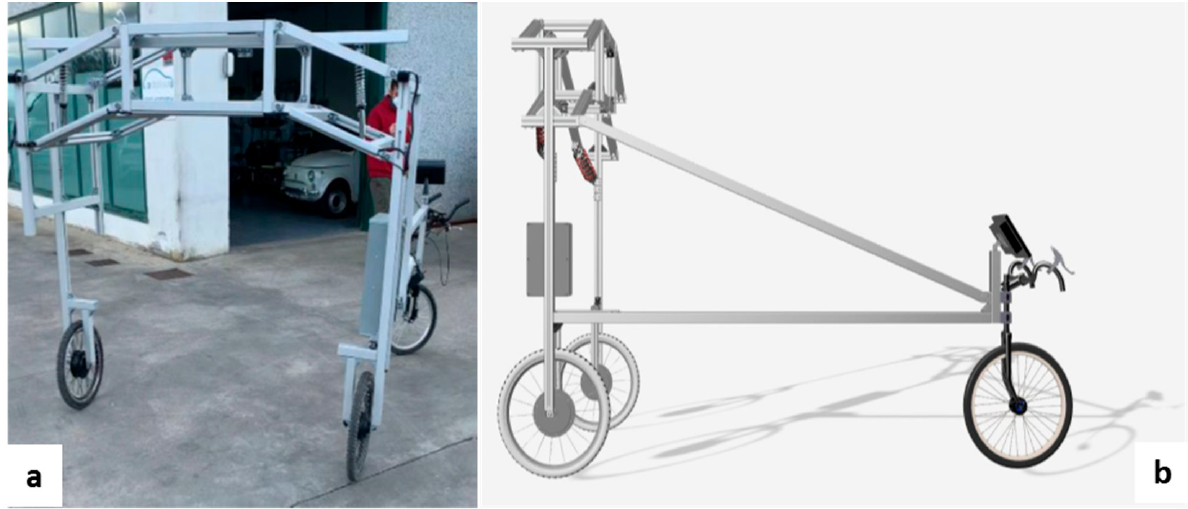
Figure 1. Chassis with double-articulated quadrilateral ( a ) and longitudinal balancer ( b ). Connected to the “double articulated quadrilateral” are the two side structures that contain the wheel motors and the front-view guide cameras (one on the left and one on the right